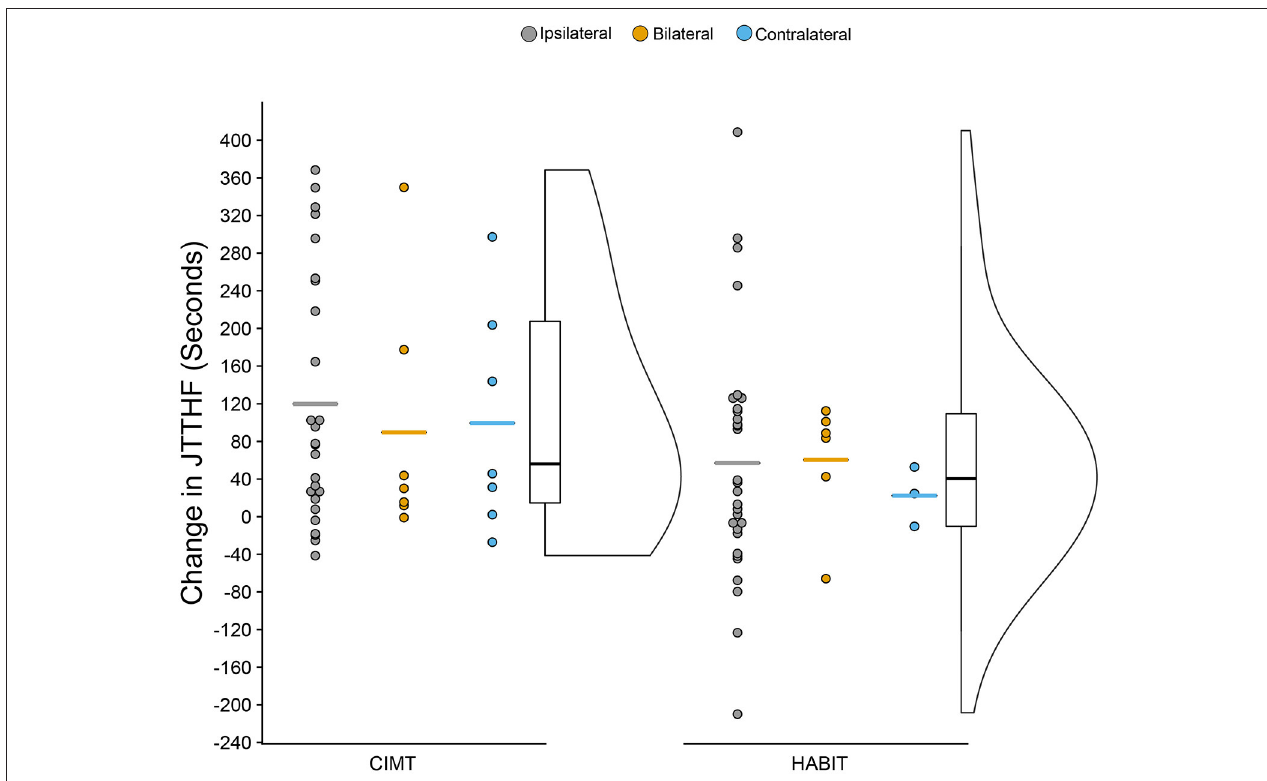
FIGURE 3 | Raincloud Plot of Changes (Pre-test to Post-test) in JTTHF by Therapy Group and CST Connectivity (positive scores =